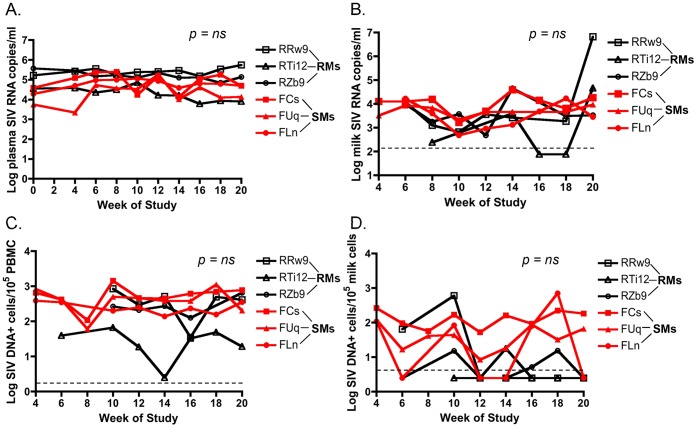
Similar cell-free and cell-associated SIV levels in blood and milk from RMs and SMs following pharmacologic induction of lactation.Lactation was induced using intramuscular injections of estradiol and medroxyprogesterone along with oral haloperidol followed by oxytocin injections to stimulate the milk ejection reflex. Over the 20 weeks of this study, plasma viral loads were measured via SIV RNA real time RT-PCR every 2 weeks (A). Breast milk was collected from RMs and SMs and cell-free SIV RNA was quantified in the de-fatted milk fraction by RT-PCR (B). Cell-associated SIV DNA was then measured in both PBMCs (C) and breast milk cells (D) with simultaneous albumin detection to determine cell number per reaction. Dashed lines represented the lower limit of detection for the assay. Undetectable values were plotted as half the lower limit of detection. Area under the curve analyses followed by nonparametric Mann-Whitney test was used to assess significance.